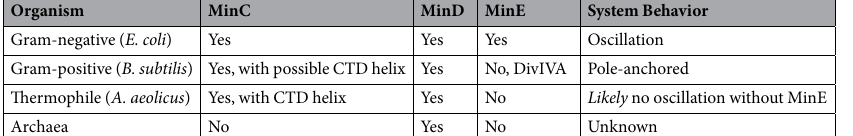
Organism MinC MinD MinE System Behavior Gram-negative ( E. coli ) Yes Yes Yes Oscillation Gram-positive ( B. subtilis ) Yes, with possible CTD helix Yes No, DivIVA Pole-anchored Thermophile ( A. aeolicus ) Yes, with CTD helix